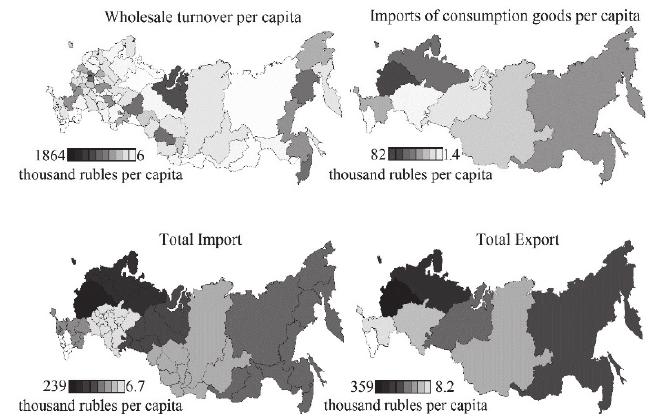
Fig. 1. Wholesale turnover, imports of consumption goods, total import and total